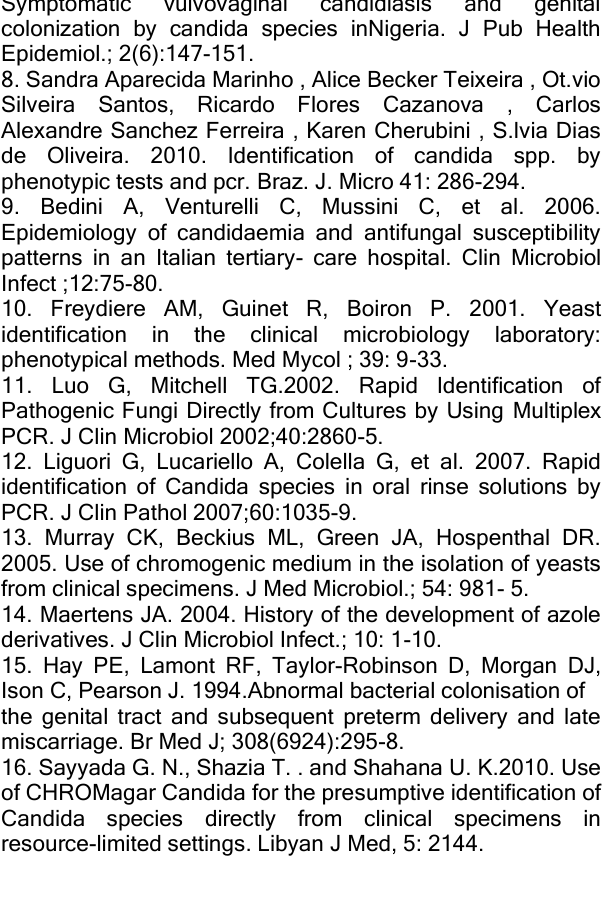
pink with white